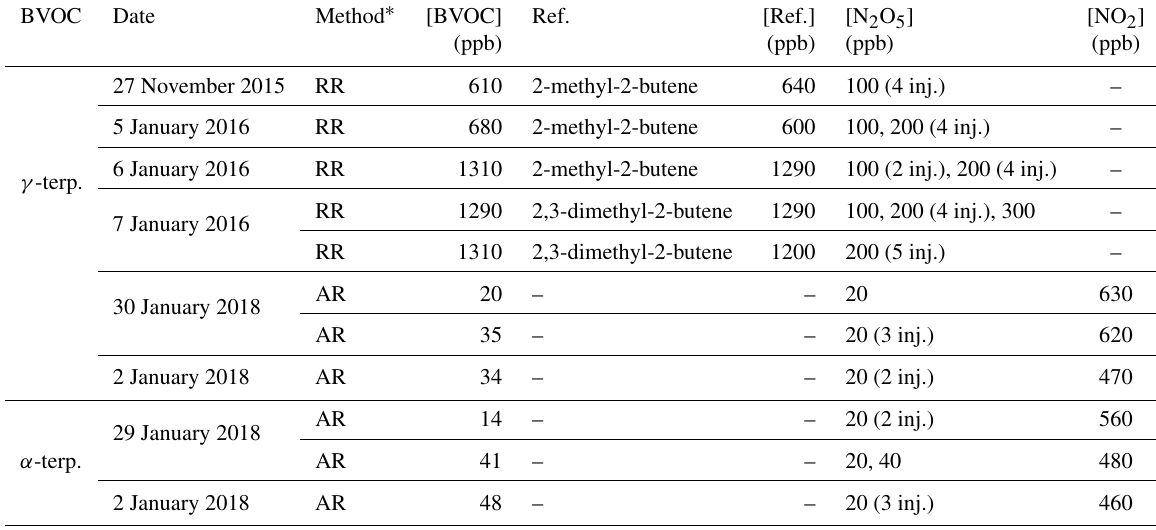
Table 1. Experimental conditions of kinetic experiments. [BVOC] is the initial concentration of BVOC; Ref. is the reference compound, and [Ref.] is the initial concentration of the reference compound. For [N 2 O 5 ] the number of punctual injections is indicated in brackets. BVOC